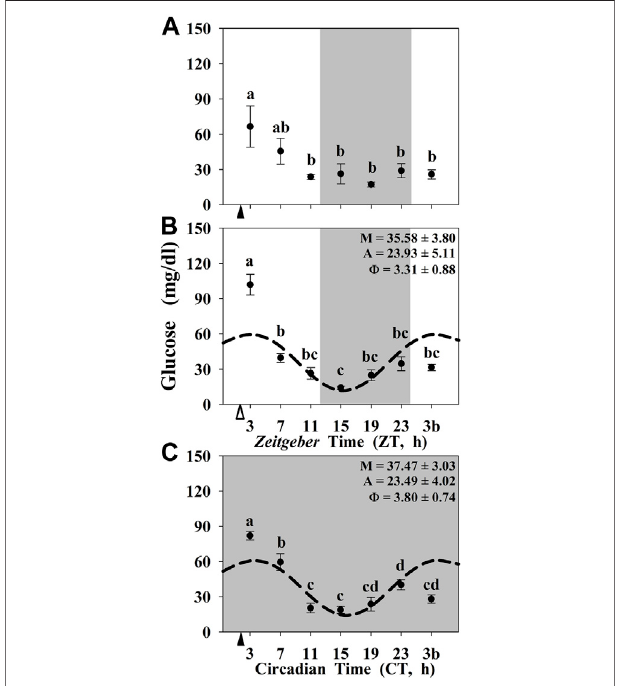
FIGURE 5 | Daily pro fi le of plasma glucose levels in gold fi sh maintained under different lighting conditions and feeding protocols. Grey area indicates the dark period. Feeding time is indicated by triangles in the x-axis (solid, ▲ , scheduled feeding at ZT/CT 2; white, Δ , random feeding with the last meal at ZT 2). Data are shown as mean ± SEM (n = 5 – 7). Different letters indicate signi fi cant differences (ANOVA p < 0.05, SNK post hoc test). When Cosinor( SE(A)/A < 0.3 )wassigni fi cantand A > 1 ,periodicsinusoidalfunctions were represented as dashed curves with the corresponding amplitudes and acrophases ( A and Φ ,